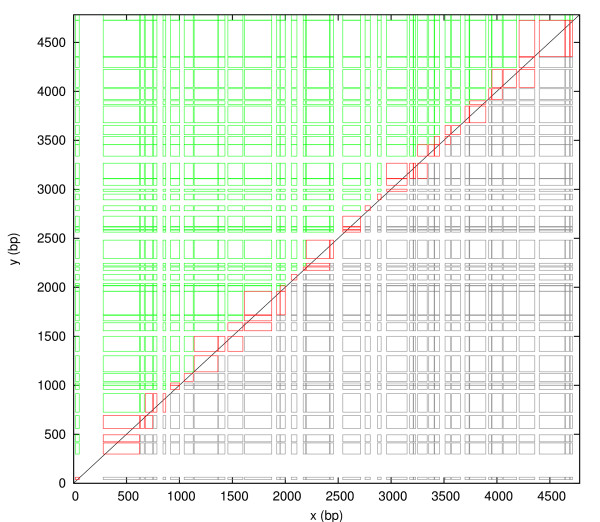
The set G = Px × Py of all grid frames plotted in the xy-plane. The grid frames are colored to distinguish those that are above the diagonal (green), crossing the diagonal (red), and below the diagonal (grey), thus illustrating the subsets Ga, Gc and Gb, respectively. Frames with side lengths below 20 bp are not shown to unclutter the figure.